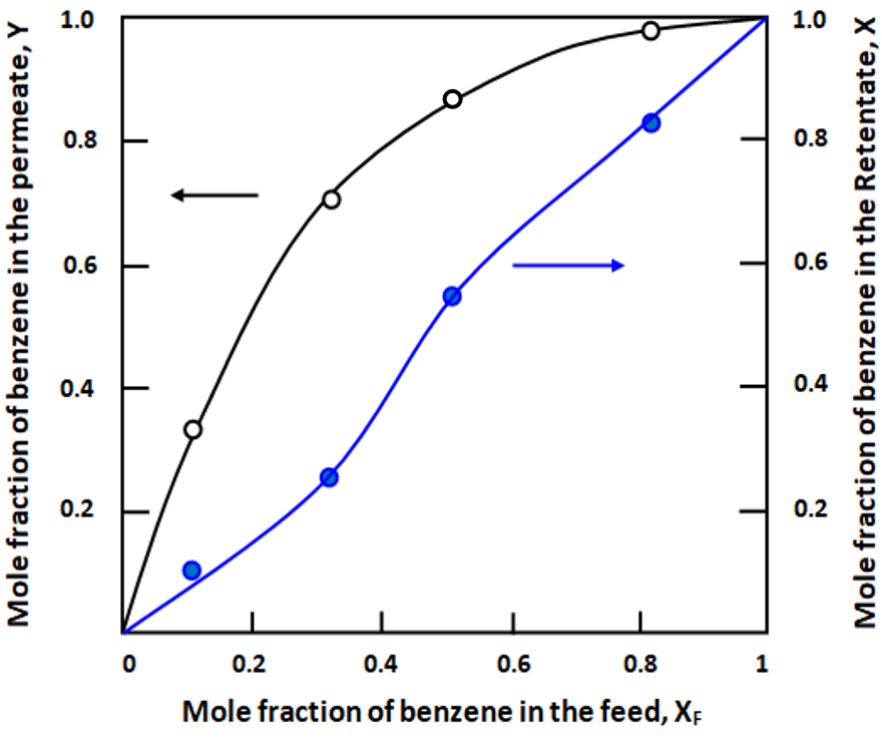
Figure 19. VLPE diagram for pervaporation of benzene/cyclohexane mixtures using E-VOH/CNT membrane at 25 °C.